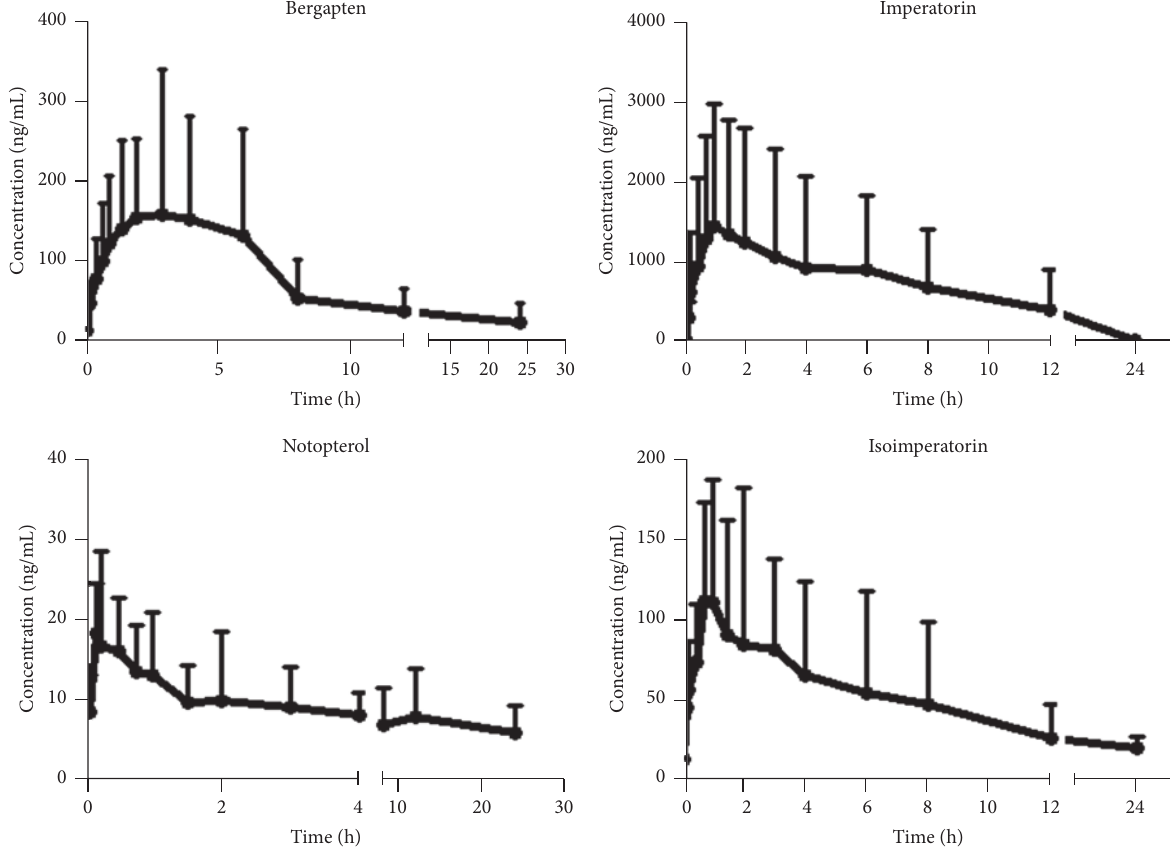
Figure 3: The mean plasma concentration-time profiles of bergapten, imperatorin, notopterol, and isoimperatorin after oral administration of N. incisum ( 𝑛 = 8 , mean ± SD). Table 5: Pharmacokinetic parameters of four coumarins after oral administration of N. incisum extract ( 𝑛 = 8 , mean ± SD). Parameters Bergapten Imperatorin Notopterol